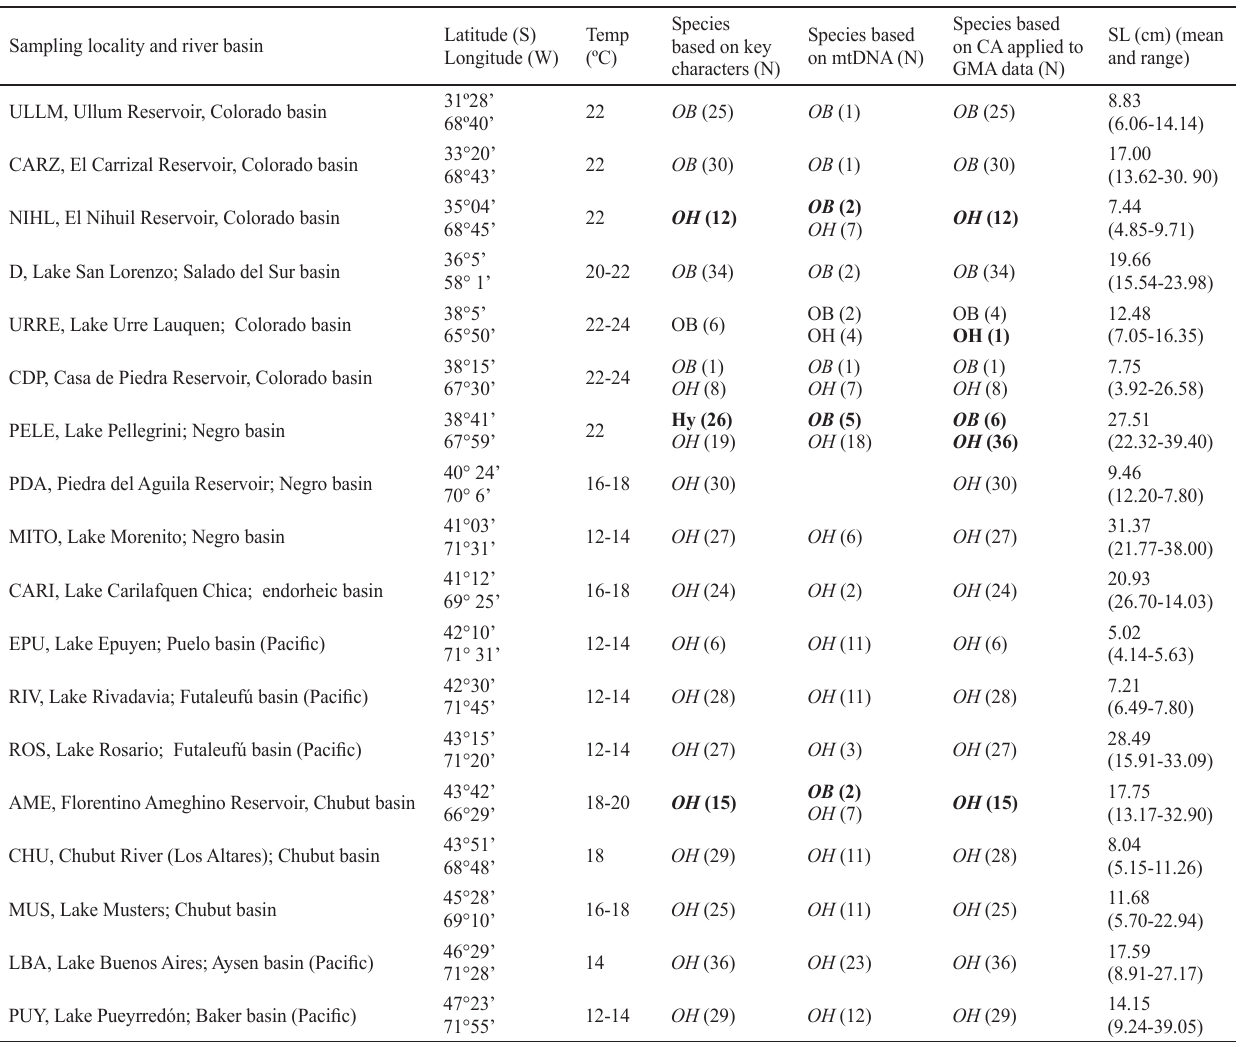
Table 1. Sampling localities, basins, latitude, longitude, mean summer air temperature 1961-1990 (Temp, data from Servicio Meteorológico Nacional, Argentina, www.smn.gov.ar), species identification, and SL of Odontesthes specimens used in this study. All river drainages flow to the Atlantic, unless otherwise noted (Pacific). OB : O. bonariensis , OH : O. hatcheri, Hy: presumptive hybrids, showing key characters of both species; CA: Cluster Analysis; GMA: Geometric Morphometrics Analysis; N: number of specimens. In bold, differences between key, genetic, and morphological criteria. Presumptive hybrids were highlighted as * in Fig. 3 and bold characters in Table